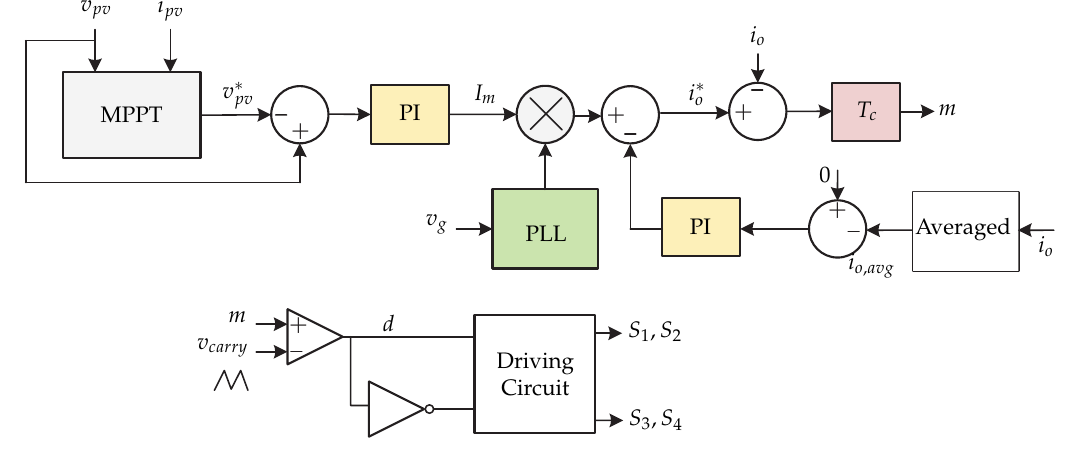
Figure 17. Control strategy proposed in [26].